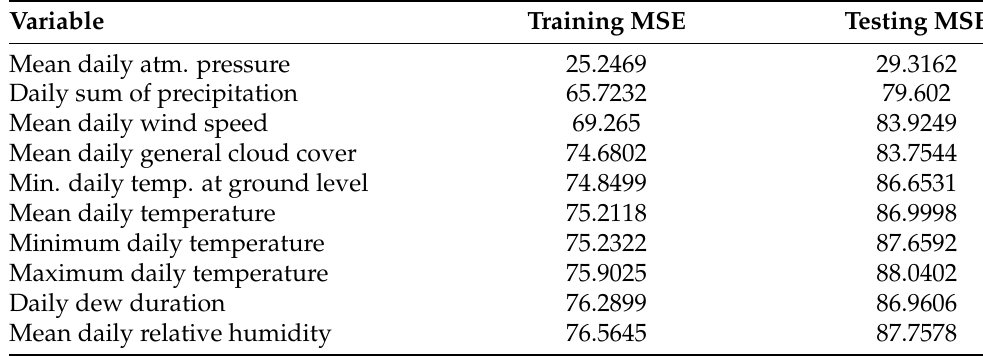
Table A9. The results of the selection of the most suitable subset of training variables for the prediction of the mean daily atmospheric pressure.